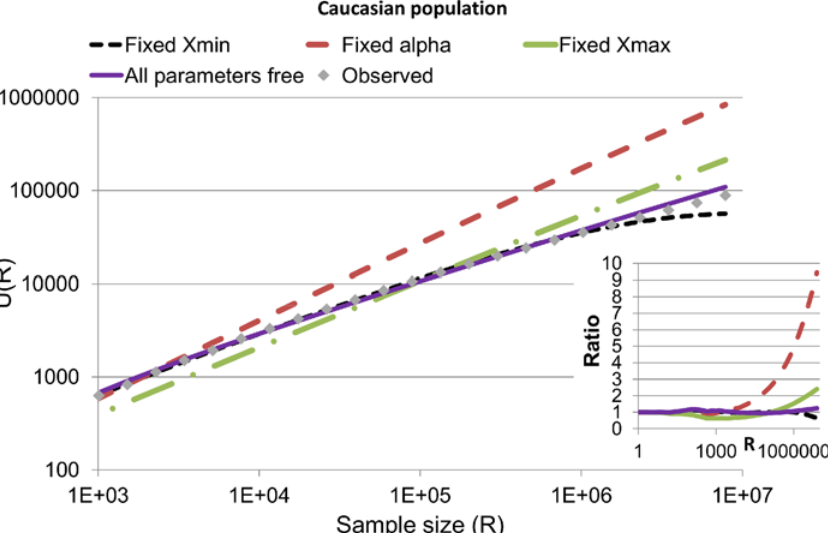
Fig 4. Comparison of computed and observed expected number of haplotypes in a sample of size R : U ( R )for the European American population for different sample sizes R. The gray squares are observations. All estimates were performed using 10% of the sample. The lines are an estimation of U ( R ) with all free parameters (full purple), maximal Xmax and free α (dashed green line), free Xmax and free α but fixed Xmin (dashed black line) and free boundaries but α based on the Clauset estimate (double dashed red line). The inset shows the ratio between the computed number of haplotypes and the real